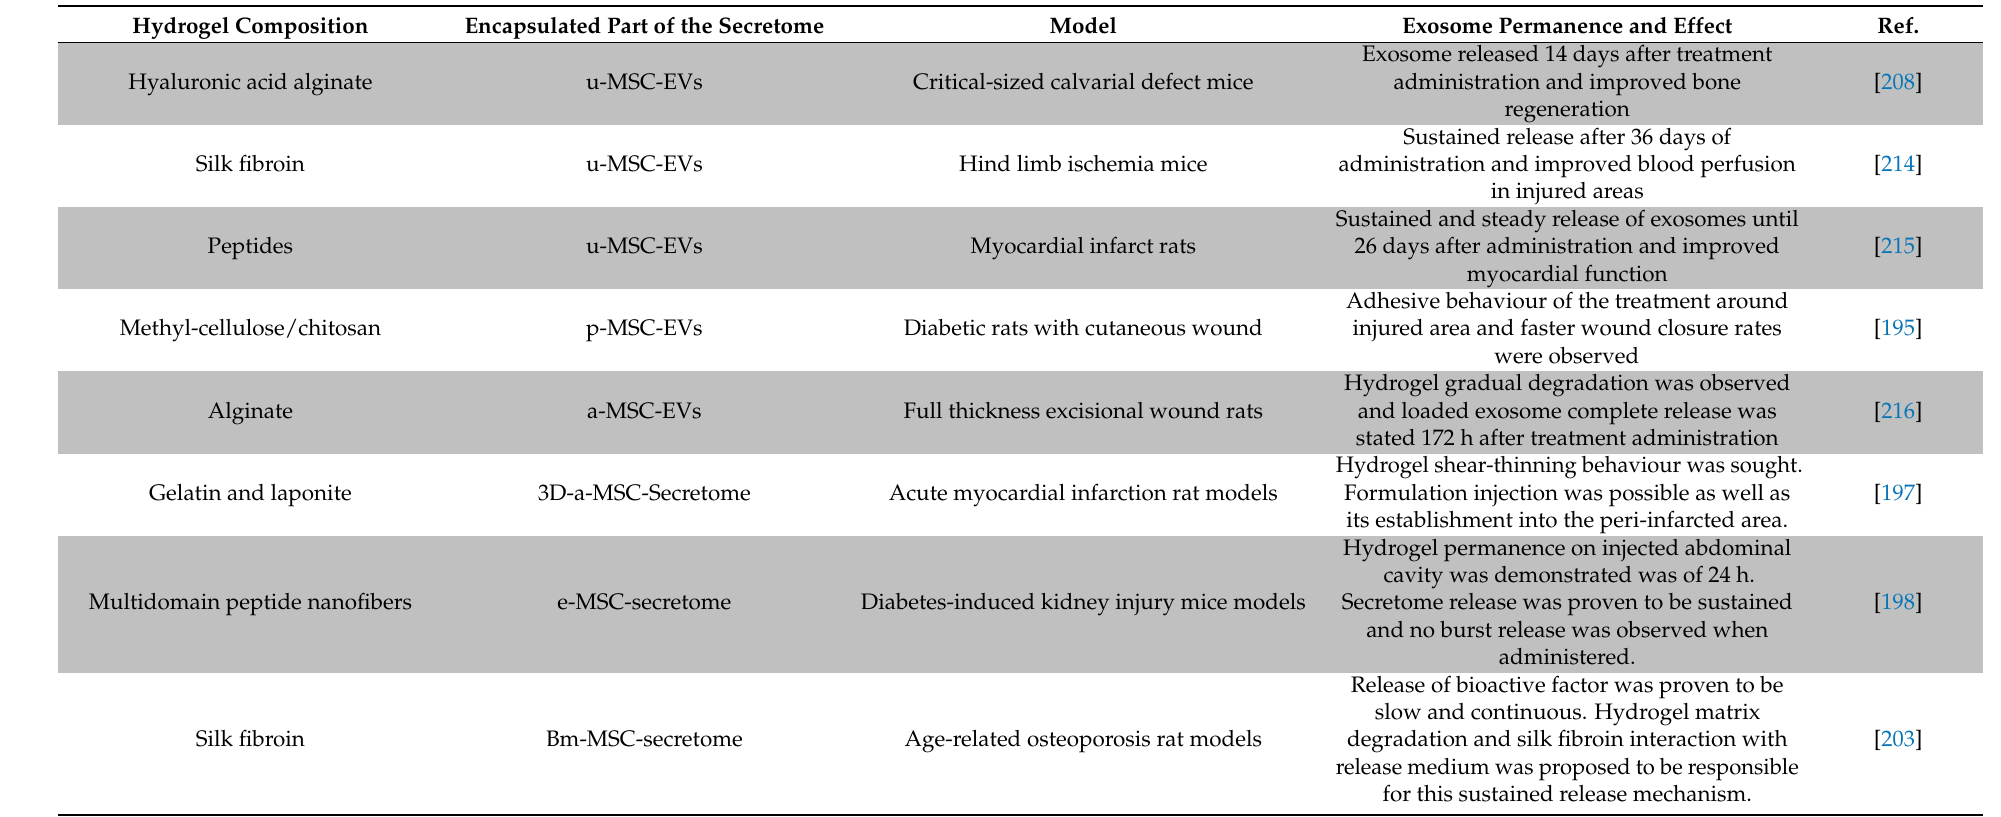
Table 2. Studies involving hydrogel encapsulation of exosomes for increased treatment permanence around injured areas. MSC-EVs (mesenchymal stromal cell-derived extracellular vesicles) u-MSCs (umbilical-derived MSCs); p-MSCs (placenta-derived MSCs); a-MSC (adipose tissue-derived MSCs) e-MSC (embryonic stromal cells) 3D-a-MSC-secretome (3D cultured adipose-derived MSC-derived